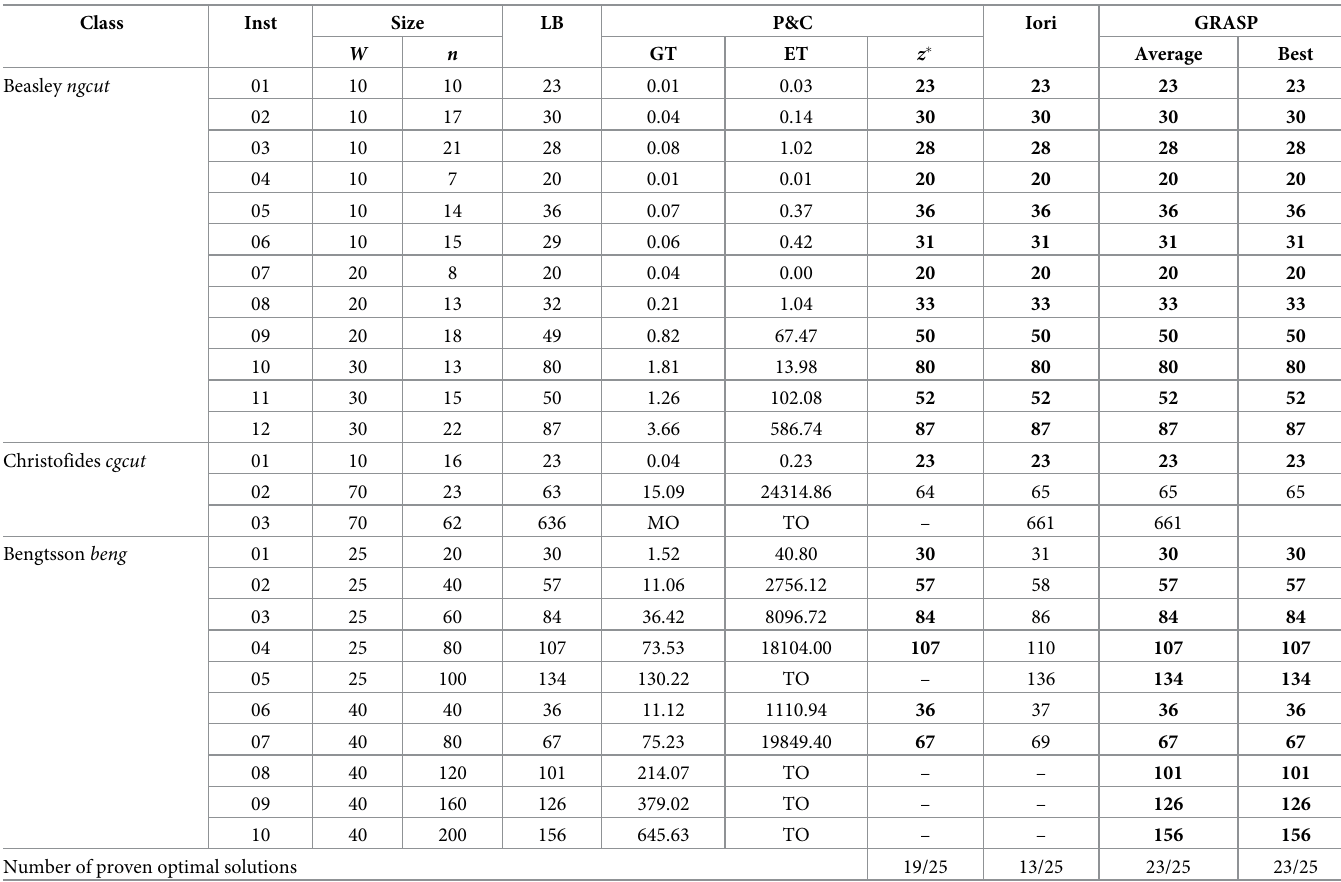
Table 7. Results for ngcut, cgcut , and beng